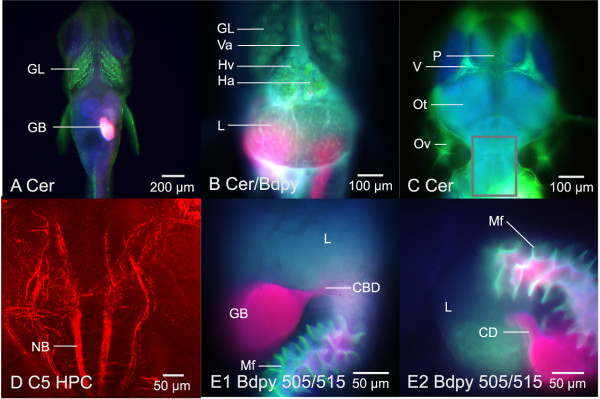
Differential uptake and transport of fluorescent probes β-Bodipy C5-HPC, Bodipy FL C5 Ceramide and Bodipy 505/515: Widefield and confocal fluorescence microscopy. (A – C) β-Bodipy C5 ceramide uptake and distribution: the ceramide fluorophore (green) exhibited properties consistent with passive diffusion across cell membranes, with distinct uptake over the gill (GL) and transport through the cardiovascular system. The fluorophore was not observed to cross the blood-brain barrier (C), though it persisted in vasculature, with a residence time of hours to days (depending on exposure regime). (D) In contrast, β-Bodipy C5 phosphocholine (HPC) was observed to label neurons in the hind brain of STII medaka. Frame D is a confocal fluorescence image (from 3D projection) of β-Bodipy C5 phosphocholine labeling neural bundles in the corpus cerebelli, crista cerebellaris and medulla, 90 minutes post fluorophore exposure (aqueous bath) (STII medaka, 18 dpf). Corpus cerebelli, crista cerebellaris and medulla are region of interest indicated by gray rectangle in frame (C). (E1 and E2) Widefield fluorescence microscopy of Bodipy 505/515 secretion (red fluorescence) from gall bladder (GB) through the cystic duct (CD) and common bile duct (CBD) into the gut lumen. Mucosol folds of the gut (Mf) are the result of β-Bodipy C5 ceramide fluorescence (co-administered with Bodipy 505/515). Ventral aorta (Va), Heart Ventricle (Hv), Heart Atrium (Ha), Liver (L), Pineal Gland (P), Optic Tectum (Ot), Otic Vesicle (Ov), Vasculature (V).